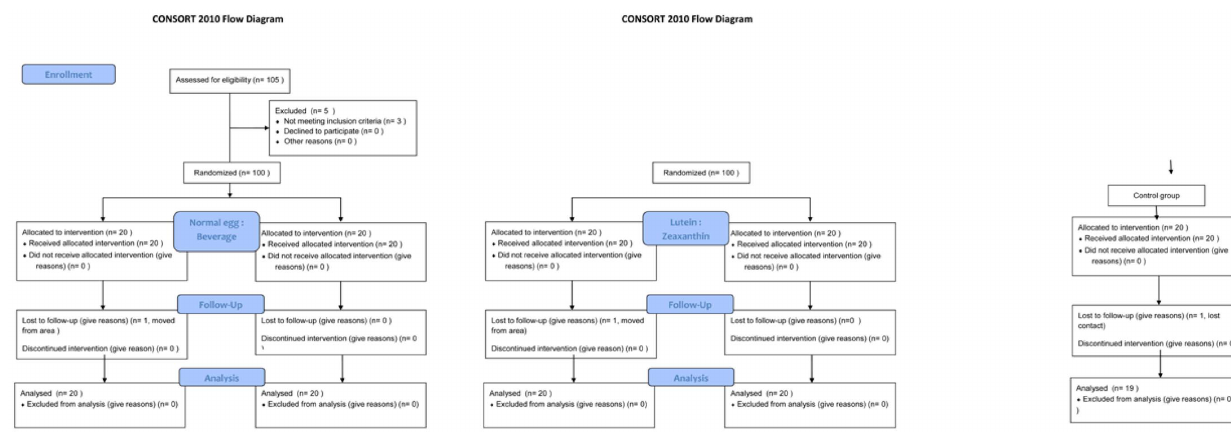
Figure 1. Flow diagram of the participants in the study.